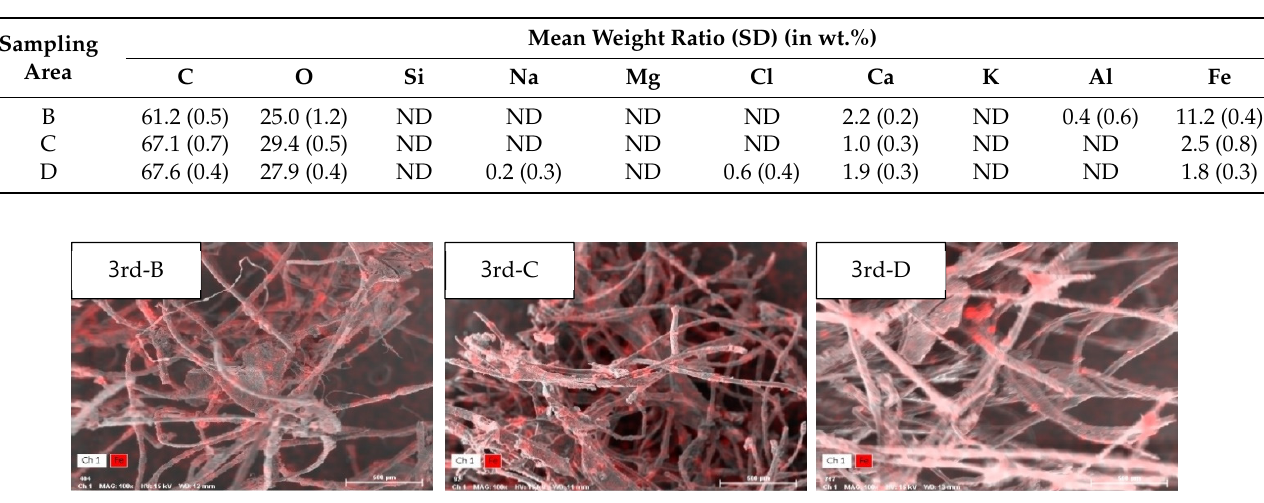
Figure 5. Element analysis of the return air, using SEM-EDS, on August 1.